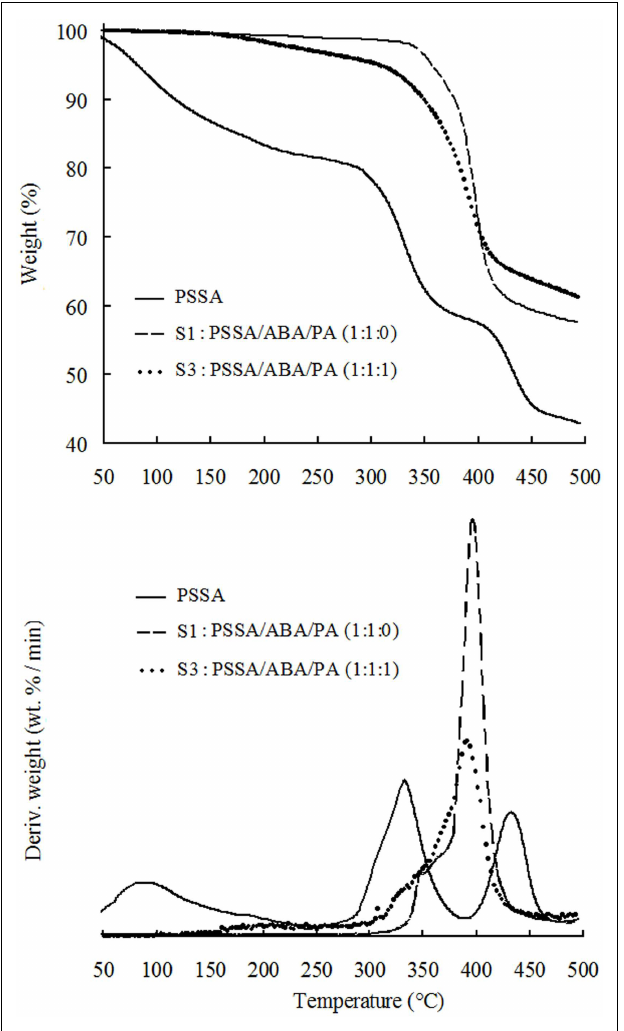
FIGURE 2 |TGA traces of PSSA, S1: PSSA/ABA/PA (1:1:0) and S3: PSSA/ABA/PA (1:1:1) composite membranes .